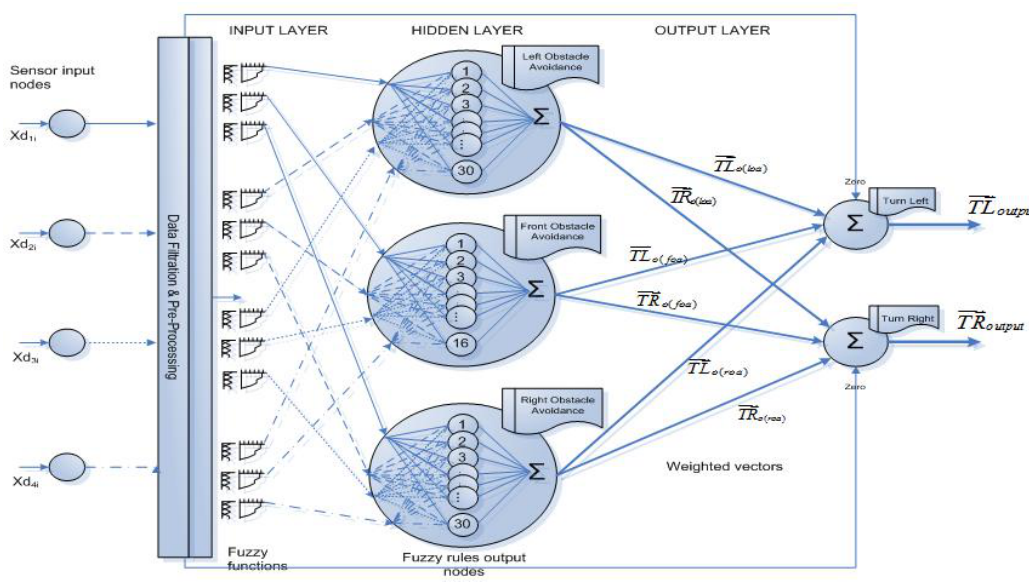
Fig. 6. Proposed neuro-fuzzy control system for the smart clothing